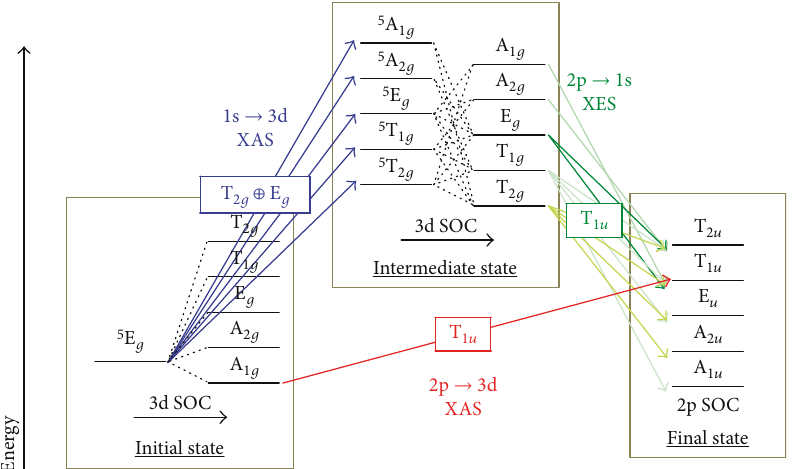
Figure 32: Multielectronic term scheme for Mn 3+ ( 3d 4 ) in high spin comparing the 1s2p RIXS and direct 2p XAS pathways. Where SOC is included, the spin multiplicity is